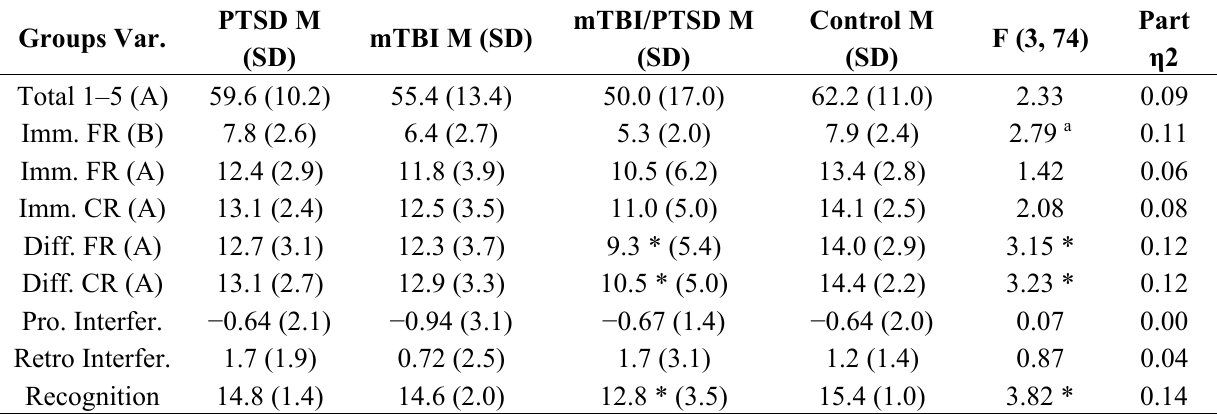
Table 4. Results on California Verbal Learning Task